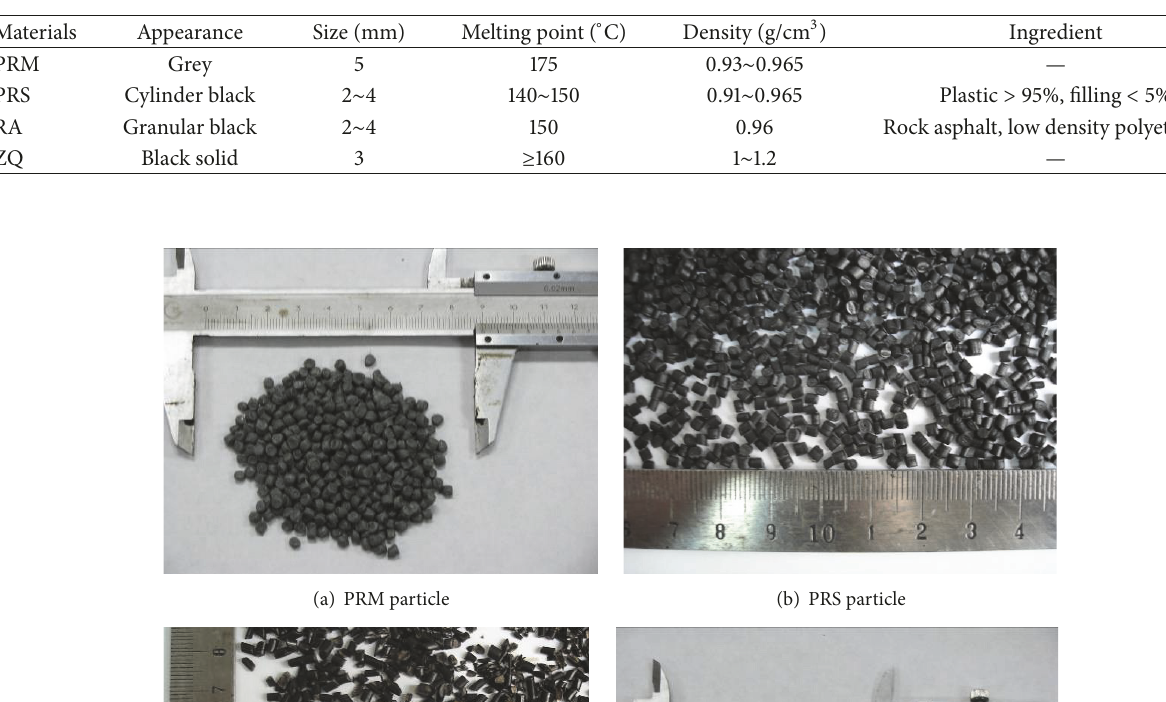
Table 4: Additives